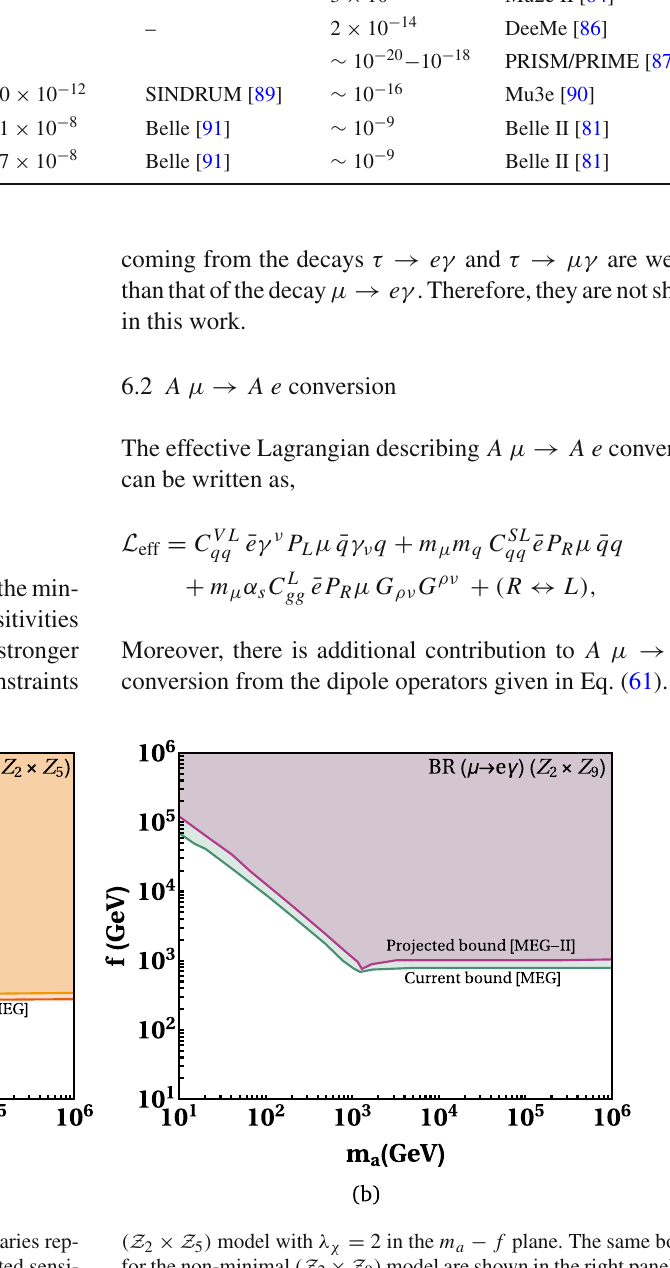
Fig. 11 In the left panel, the red and yellow coloured boundaries rep- resent the allowed parameter space by the current and projected sensi- tivities of the MEG experiment on the BR (μ → e γ) for the minimal